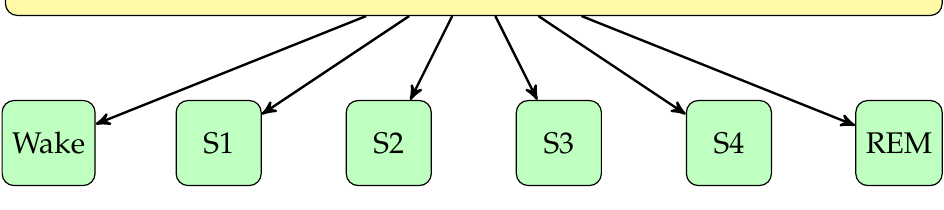
Figure 1. Flowchart of the proposed